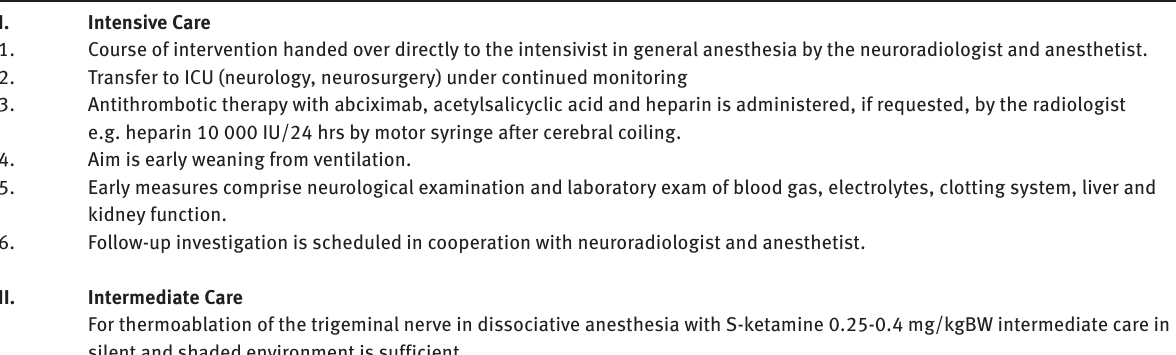
Table 3: Postoperative SOP after